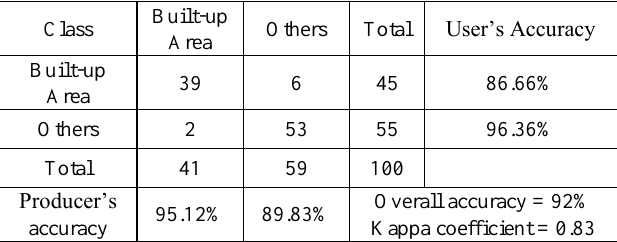
Table 2. Results of accuracy assessment for Zone